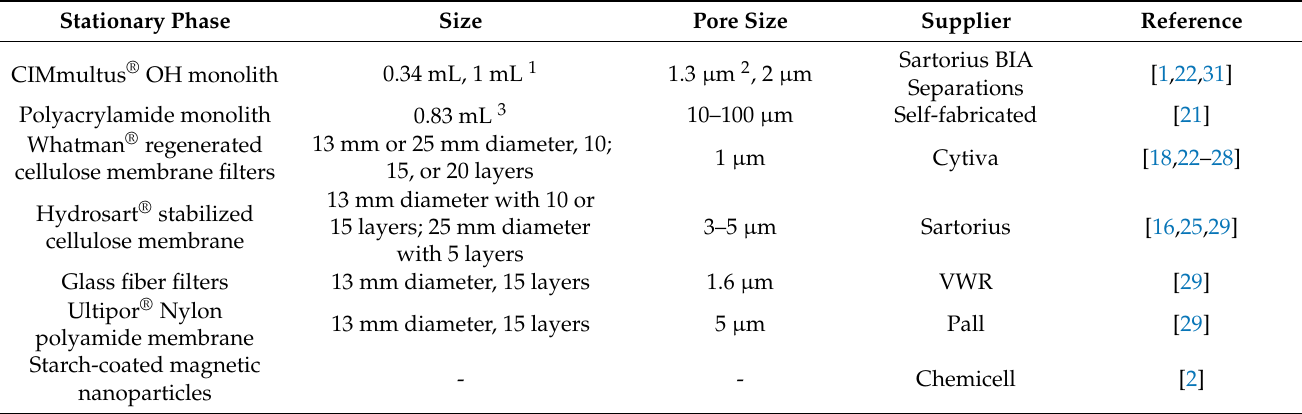
Table 1. Stationary phases used for